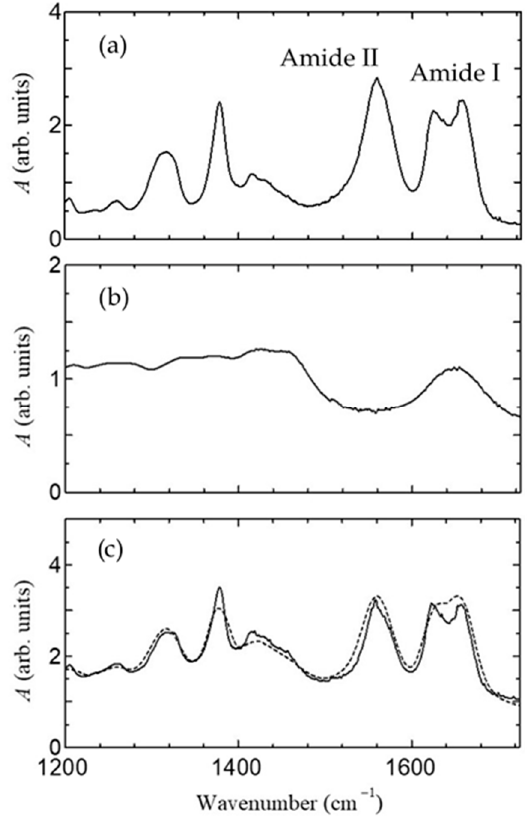
Figure 6. IR spectra in chitin film ( a ), PSII solution ( b ), and the PSII–chitin composite film ( c ).